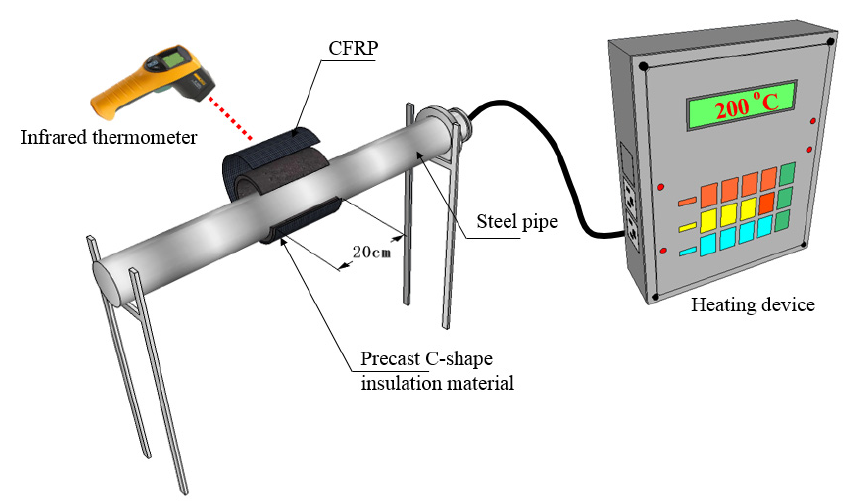
Figure 11. Illustration of experimental setup for high-temperature pipeline strengthening method.